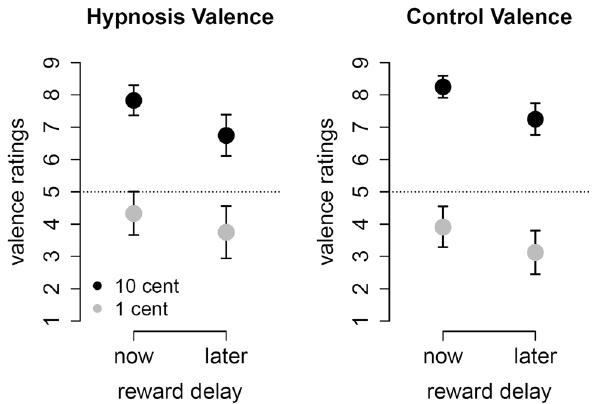
Figure 4. Participants rated higher and immediate rewards as more positive than lower and delayed rewards. In the hypnosis condition, participants rated higher rewards as less positive and lower rewards as less negative compared to the control condition. The dotted line indicates a neutral evaluation. Error bars are 95% confidence intervals.